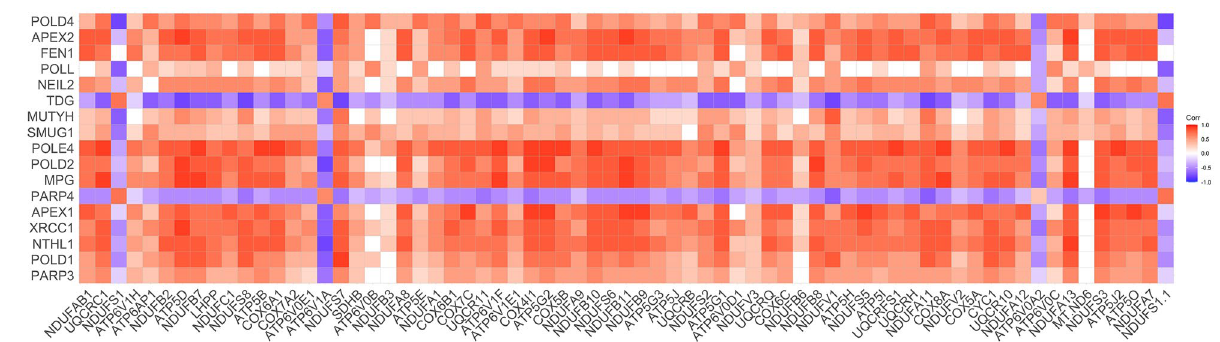
Figure 4. Correlations between differentially expressed OXPHOS (x-axis) and base-excision repair (y-axis)